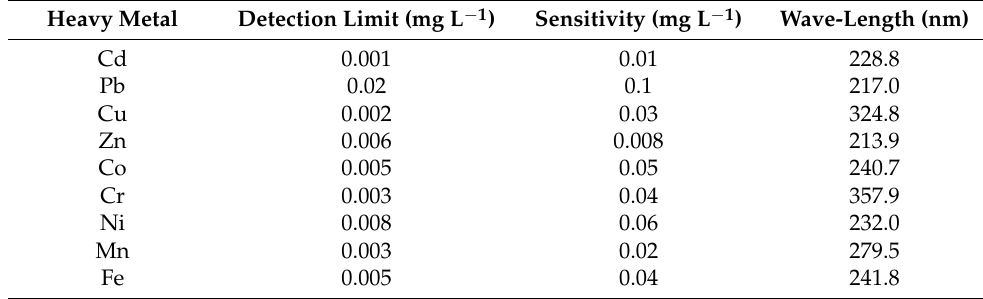
Table 3. Condition of Atomic Absorption Spectroscopy measurements of heavy